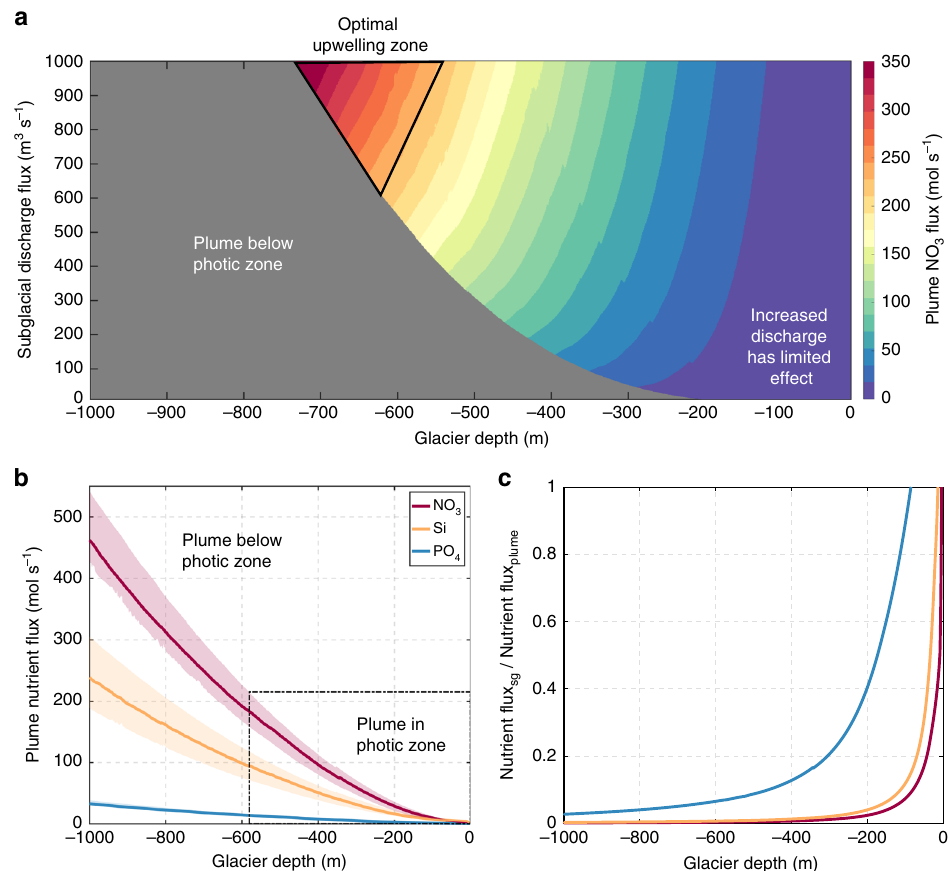
Fig. 4 Regulation of upwelled macronutrient fl ux by the subglacial discharge fl ux and glacier grounding line depth. a NO 3 fl ux as a function of subglacial discharge fl ux (m 3 s − 1 runoff) and glacier depth (relative to sea-level). The gray region shows where the plume equilibrates below the photic zone (de fi ned as 0 – 50 m). b Macronutrient fl uxes for a constant subglacial discharge of 500 m 3 s − 1 , with varying glacier grounding line depth. Upper and lower shaded error bars are de fi ned as 25 and 75% quartiles on macronutrient, temperature, and salinity data (Supplementary Fig. 2). c The relative importance of the macronutrient fl uxes sourced from subglacial discharge (sg) and from entrainment into the plume. For marine-terminating glaciers, the plume macronutrient fl ux is generally dominated by nutrients from entrained